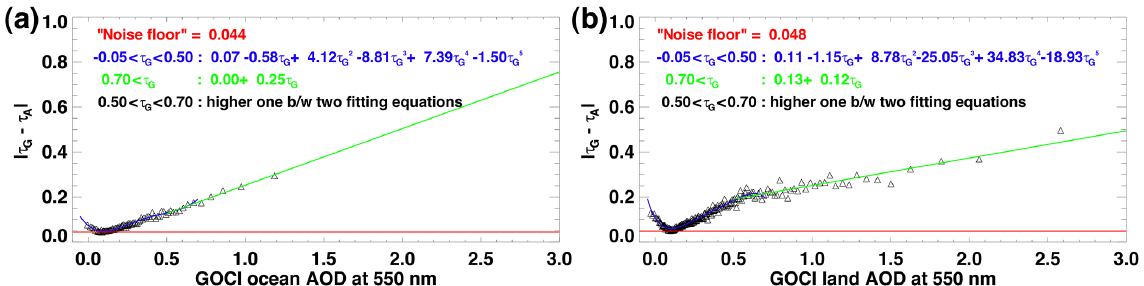
Figure 10. Absolute difference between GOCI YAER V2 AOD and AERONET AOD in terms of (a) GOCI YAER V2 ocean AOD and (b) GOCI YAER V2 land AOD. The triangle symbols represent the 68th percentiles of 200 collocated data points sorted in ascending order of x axis value.